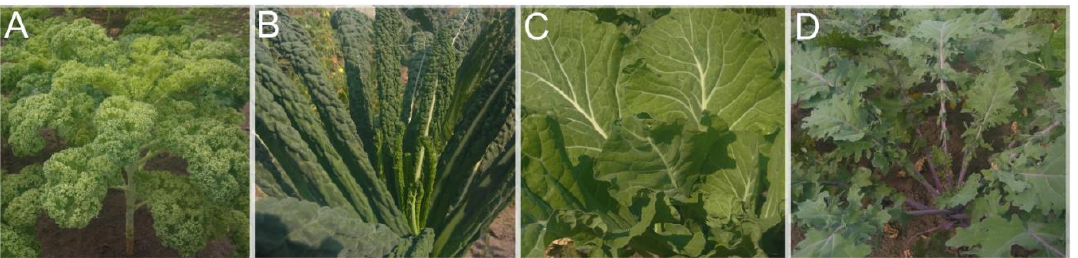
Figure 1. Different types of kale cultivars. ( A ) Curly kales, ( B ) Italian kales, ( C ) collards primary found in the USA, and ( D ) Russian or Siberian kales.